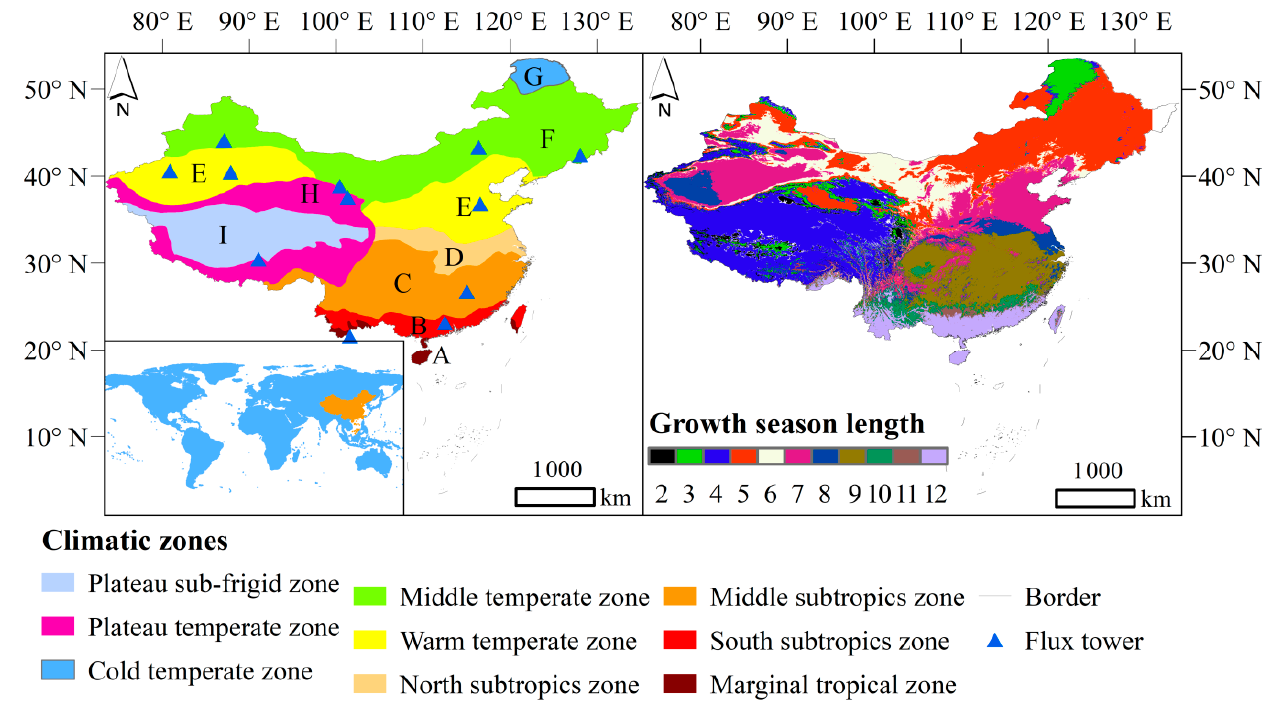
Figure 1. Sketch map of climatic zones ( left )and the length of growing seasons ( right ) in the terrestrial ecosystemsof China.